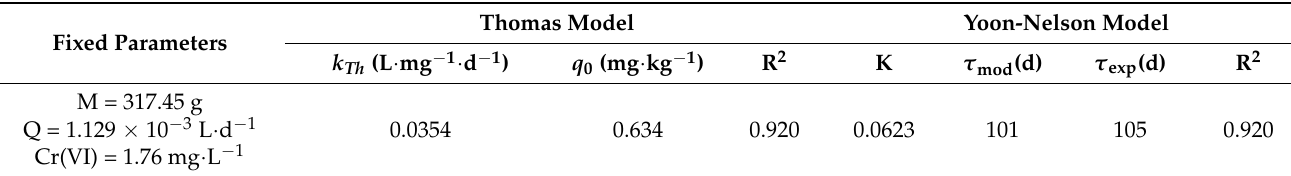
Figure 6. Fitting diagrams of ( a ) the Thomas and ( b ) Yoon–Nelson models. Table 5. Dynamic parameters of the